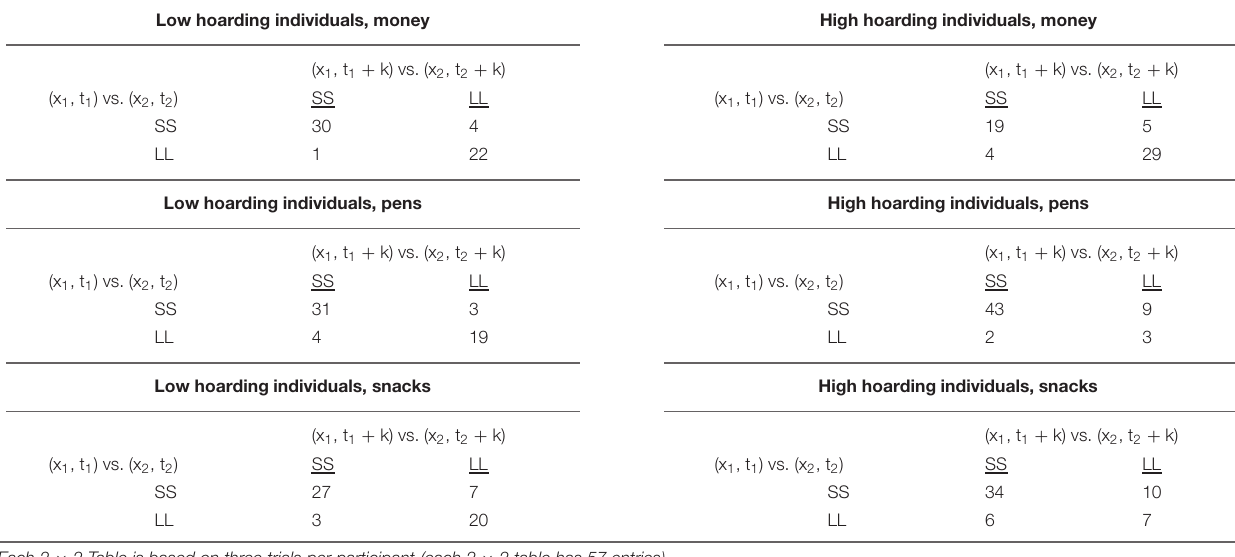
TABLE 3 | Cross-tabulations by group and domain for tests of exponential discounting, with a constant added to both times with (x 1 , t 1 vs. x 2 , t 2 ) compared to (x 1 , t 1 + k vs. x 2 , t 2 + k). Low hoarding individuals, money High hoarding individuals, money